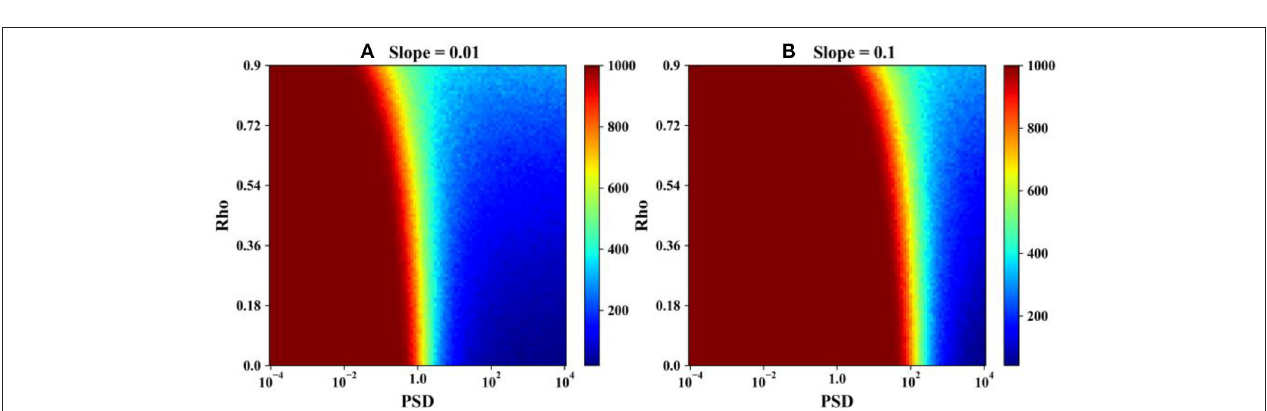
1 and (B) PSD 10 2 . = =